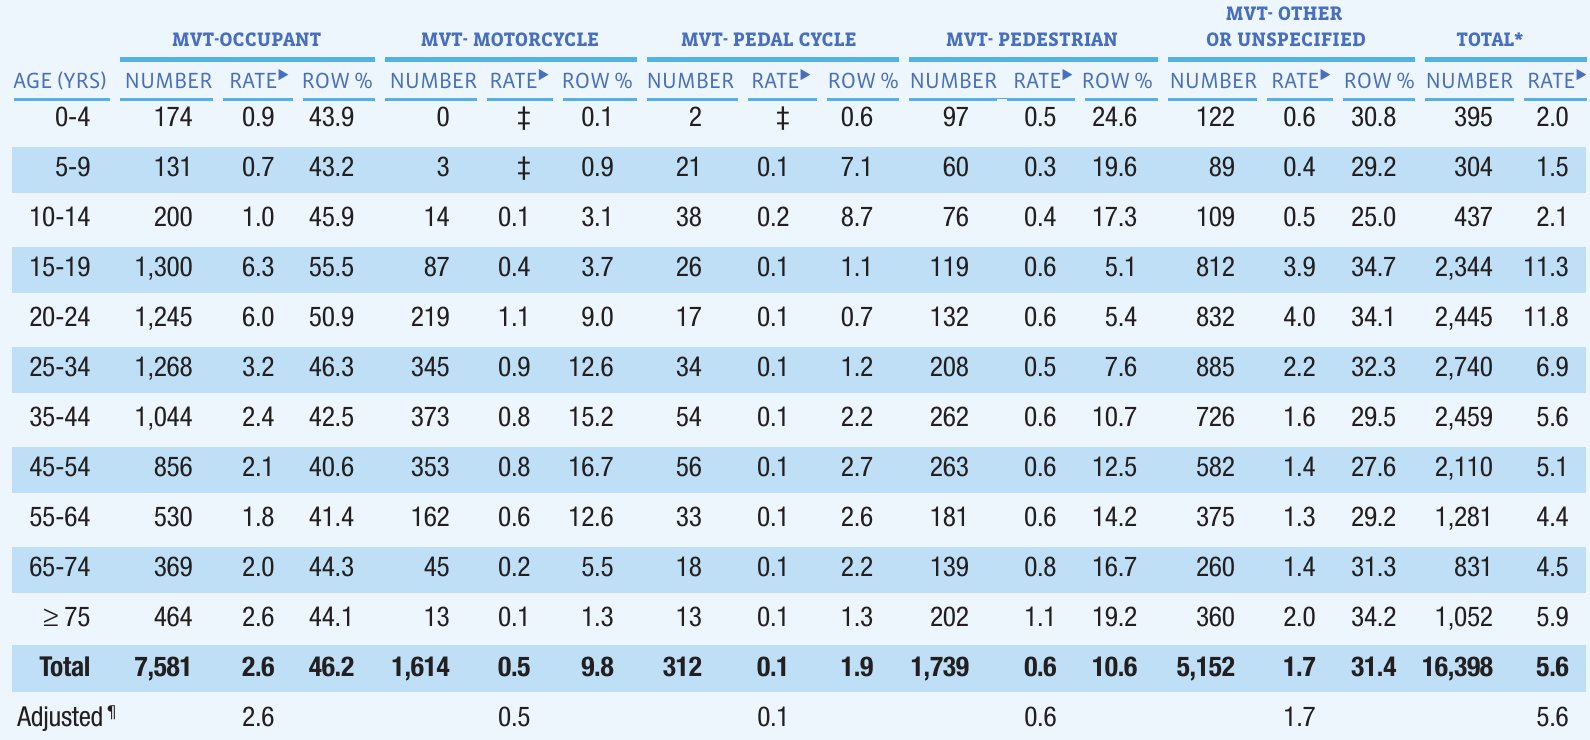
TABLE 17: Average Annual Numbers, Rates, and Percentages of Traumatic Brain Injury-Related